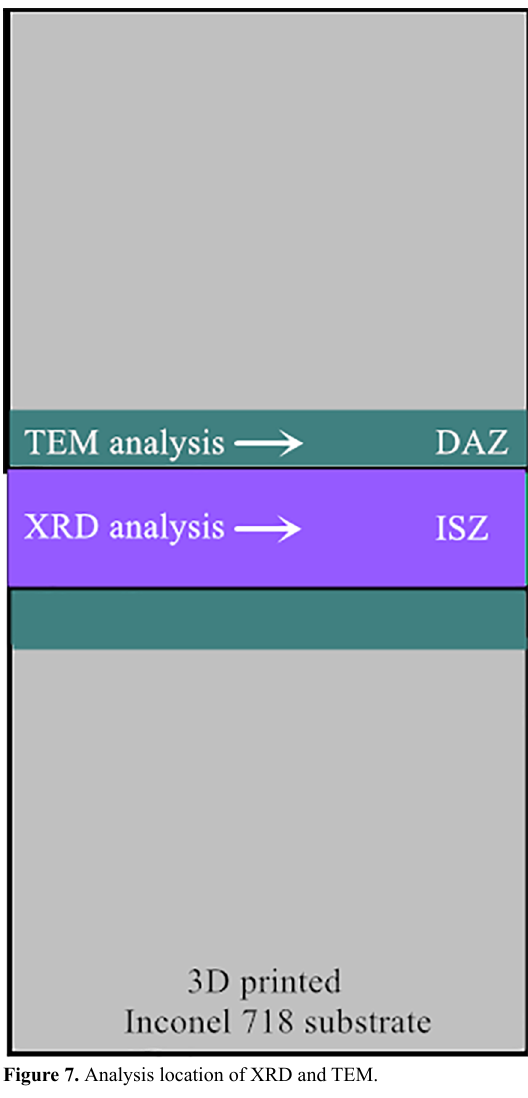
Figure 7. Analysis location of XRD and TEM.